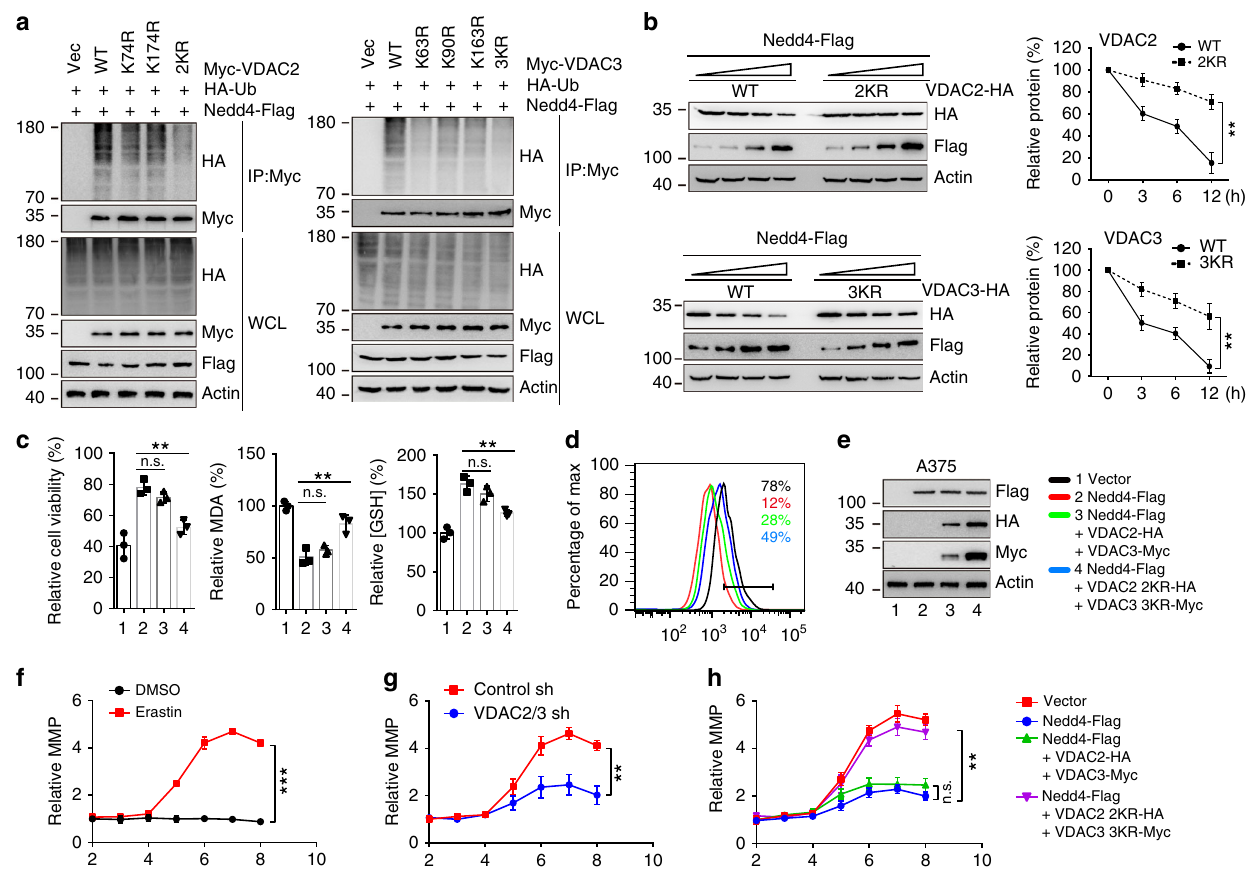
Fig. 5 Nedd4 regulates VDAC2/3 degradation through speci fi c ubiquitination sites. a A375 cells were transfected with combinations of DNA constructs as indicated and treated with MG132 for 4 h. Lysates were immunoprecipitated with anti-Myc, and western blots were performed to analyze the presence of indicated proteins and levels of ubiquitination. b A375 cells were transfected with combinations of DNA constructs as indicated and treated with erastin (5 µ M) for indicated time. Cell lysates were analyzed by immunoblotting with indicated antibodies. The protein level of VDAC2/3 was quantitated by Image J and normalized to actin levels. c – e Overexpression of KR mutants of VDAC2/3 partially rescued the cell sensitivity to erastin, which was inhibited by Nedd4. A375 cells were transfected with indicated DNA constructs for 48 h and treated with erastin (5 µ M) for 12 h. Cell viability, intracellular MDA, and GSH levels were measured ( c ). The lipid ROS level was assessed by fl ow cytometry using C11-BODIPY ( d ). The protein levels of overexpressed constructs were assessed by immunoblotting ( e ). f Quanti fi cation of MMP during erastin-induced ferroptosis. A375 cells were treated with erastin and 50 nM TMRE was added 20 min before each indicated time point. g Suppression of VDAC2/3 inhibited ferroptosis-associated MMP hyperpolarization. A375 cells expressing indicated shRNA constructs were treated with erastin and 50 nM TMRE was added 20 min before each indicated time point. h Overexpression of VDAC2/3 KR mutants rescued MMP hyperpolarization which was inhibited by Nedd4. A375 cells expressing indicated constructs were treated with erastin and 50 nM TMRE was added 20 min before each indicated time point. Fluorescence images were acquired using a microscope and mean fl uorescence was calculated by Image J software. Data shown represent mean ± SD from three independent experiments. Comparisons were made using Student ’ s t test. ** p < 0.01; *** p < 0.001; n.s. not signi fi To con fi rm the essential function of K63, K90, and K163 sites, we also generated a series of R to K mutations of VDAC1. As expected, overexpression of Nedd4 signi fi cantly increased the ubiquitin conjugation of both individual and combination RK mutants of VDAC1 (Supplementary Fig. 7b). Also, the degrada- tion of VDAC1 3RK was signi fi cantly increased in A375 cells transfected with Nedd4-Flag (Supplementary Fig. 7c) or treated with erastin (Supplementary Fig. 7d). To determine the biological function of the three K sites, we cotransfected WT or KR mutants of VDAC2/3 with Nedd4 shRNA into A375 cells. As shown in Fig. 5c – e and Supplementary Fig. 8a – c, overexpression of KR mutants partially rescued erastin-induced ferroptotic cell death, which was suppressed by Nedd4 overexpression. In contrast, depletion of VDAC2/3 inhibited erastin-induced ferroptosis, which was enhanced upon Nedd4 suppression in both A375 and G-361 cells (Supplementary Fig. 8e – h). These results suggest that VDAC2/3 is an essential target of Nedd4 in erastin-induced